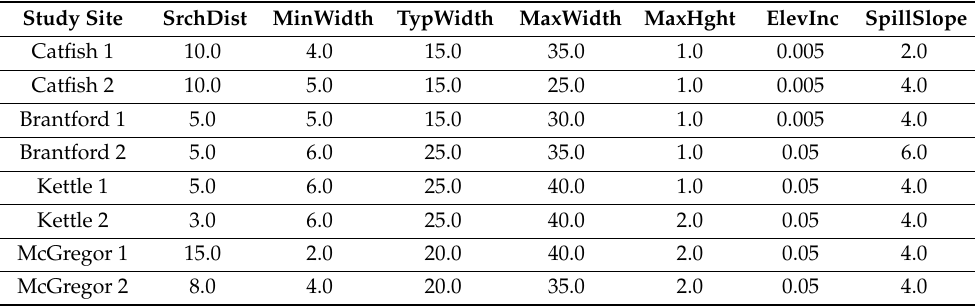
Table 3. User-defined parameter settings for each of the eight study sites. SrchDist refers to the seed repositioning search distance. MinWidth refers to the minimum road width. TypWidth refers to the typical embankment width. MaxWidth refers to the maximum embankment width. MaxHght refers to the maximum embankment height. ElevInc refers to the maximum upward elevation increment. SpillSlope refers to the spill-out slope. All parameters are specified in map units, except for SpillSlope, which is specified in degrees.